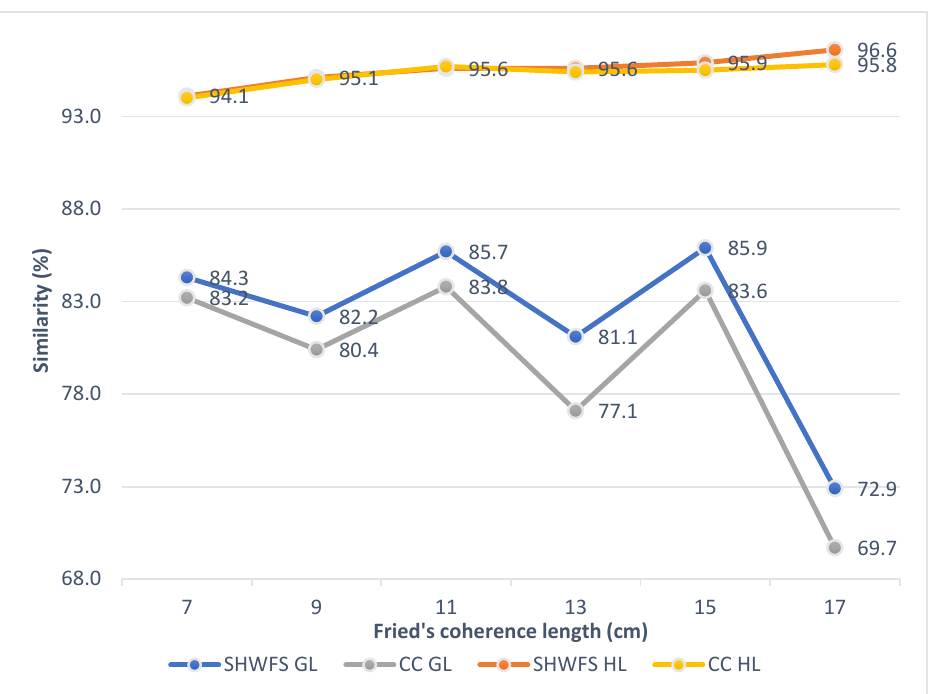
Figure 9. Comparison of the similarity obtained by both methods for ground layer (GL) and high- altitude layer (HL) situations. Note that the markers in the figure are fixed for each ANN model.